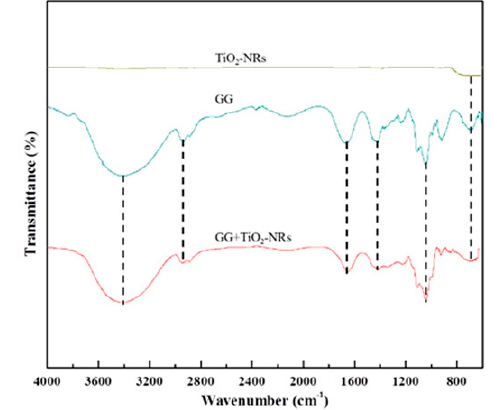
-NRs, GG, and GG+TiO 2